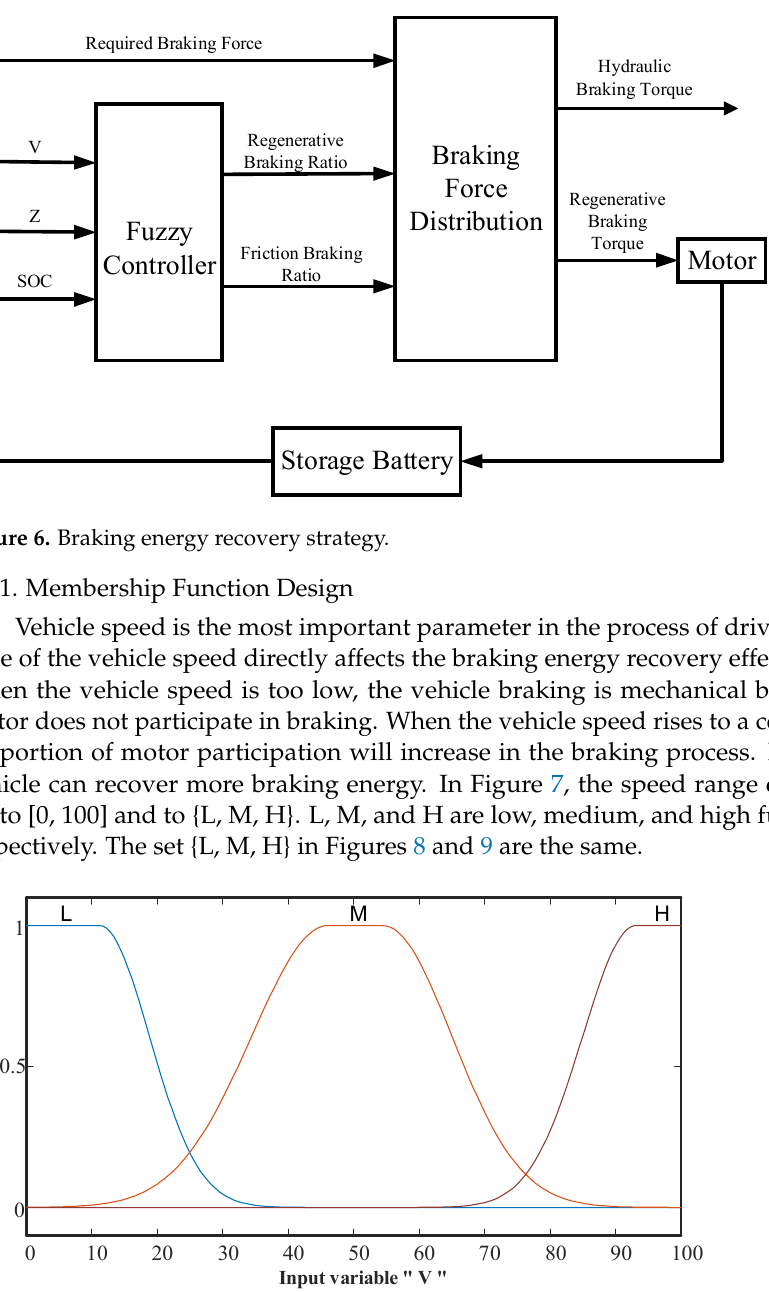
Figure 7. Vehicle speed membership function.